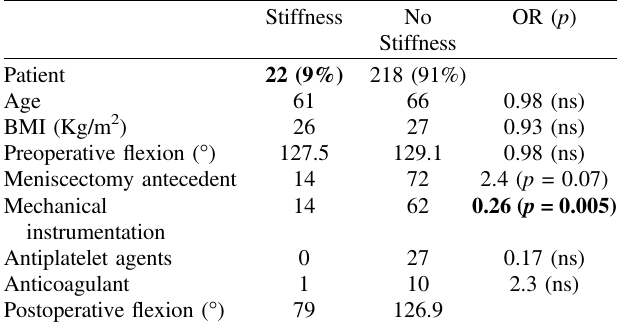
Table 3. Stiffness incidence and risk factors/ ns: no signi fi cant, OR: odds ratio .